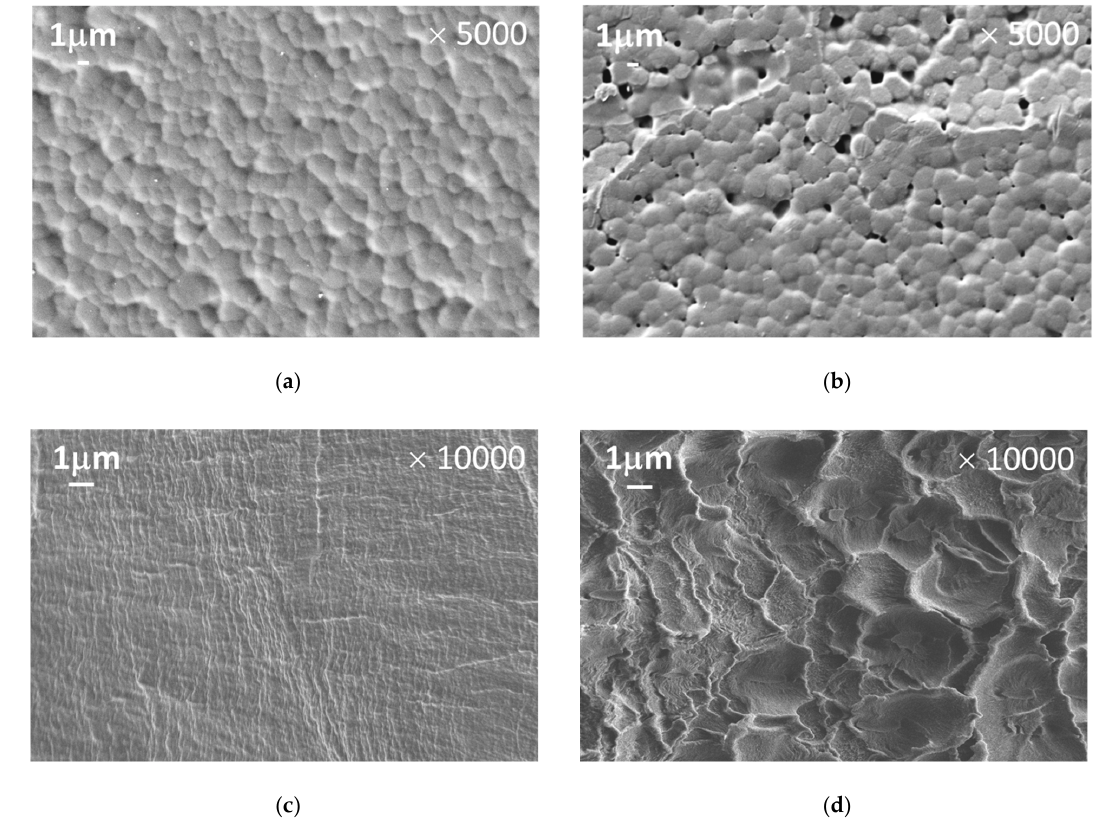
Figure 2. SEM images of ( a , b ) surface and ( c , d ) cross-section for ( a , c ) poly(2,6-dimethyl-1,4-phenylene oxide) (PPO) and ( b , d ) PPO/HAS (5%) membranes.